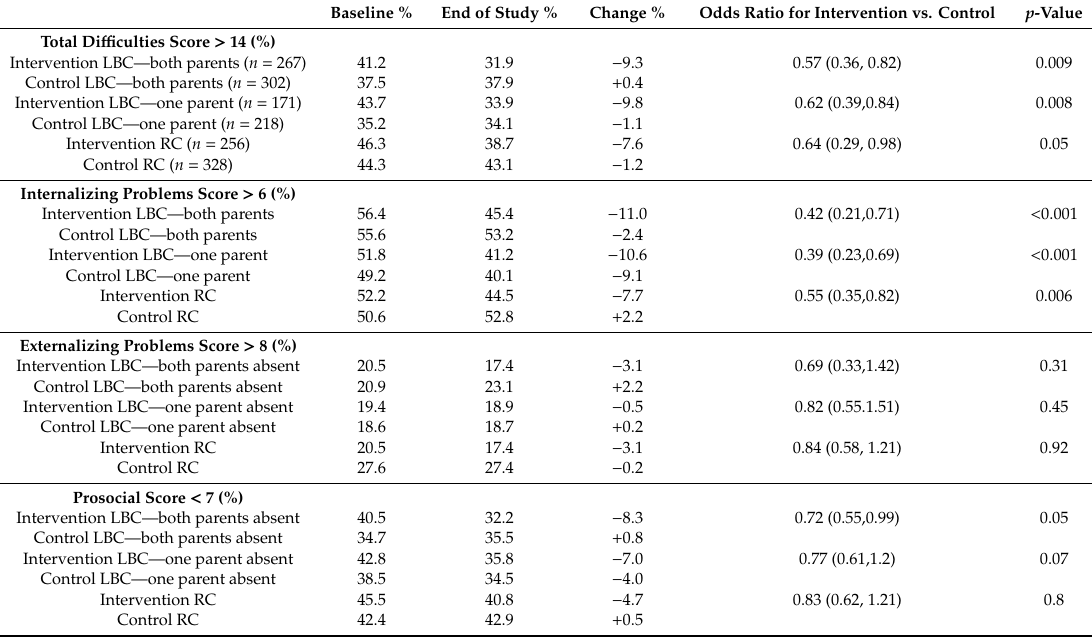
Table 2. Baseline and end-of-study assessments of children in intervention villages and children in control villages by left-behind status—Strengths and Di ffi culties Questionnaire (SDQ) Baseline % End of Study % Change % Odds Ratio for Intervention vs. Control p